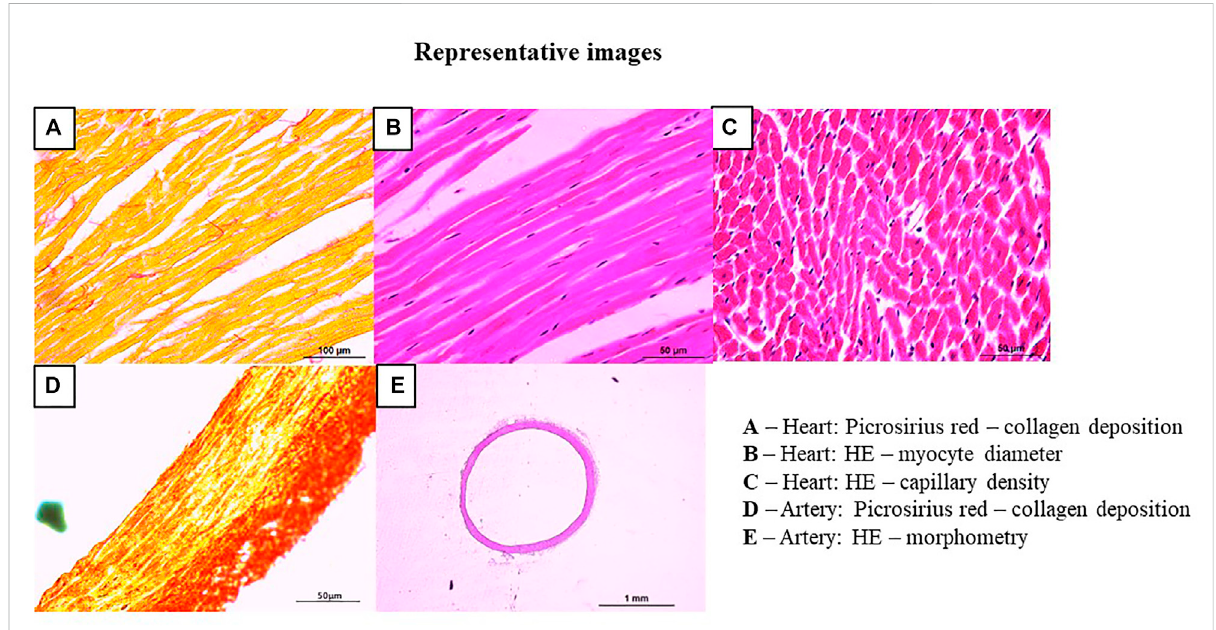
FIGURE 2 Representative images of histological analyses of the heart and arteries. Panel (A) myocardial collagen deposition: myocardial longitudinal sections of 7 µmthick werestained with Picrosirius Red and documented at×400 magni fi cation: myocytes can beidenti fi edinyellow and the fi bers ofcollageninred(bar-100 µm);Panel (B) myocytediameter: myocardial longitudinalsectionof5 µmthickwerestainedwithhematoxylinand eosin staining and documented at ×200 magni fi cation (bar-50 µm); Panel (C) myocardial capillary density: myocardial transversal section of 5 µm thick were stained with hematoxylin and eosin staining and documented at ×200 magni fi cation (bar-50 µm); Panel (D) arterial collagen deposition: arterial transverse sections of 5 µm thick were stained with Picrosirius Red and documented at ×200 magni fi cation: smooth muscle (in yellow) and collagen fi bers (in red) (bar-50 µm); Panel (E) vessel morphometry: arterial section of 10 µm thick were stained hematoxylin and eosin staining and documented at ×25 magni fi cation